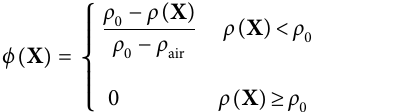
Frontiers in Earth Science |